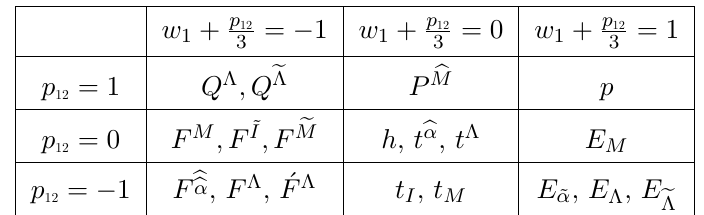
the level of T 12 ) is centred around p 12